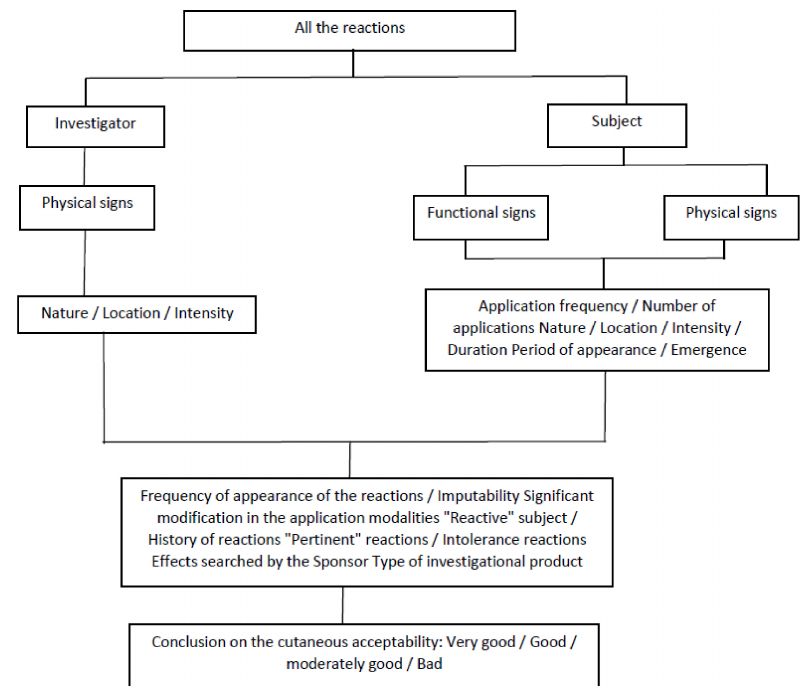
Figure 2. Generic and systematic approach to report Cutaneous